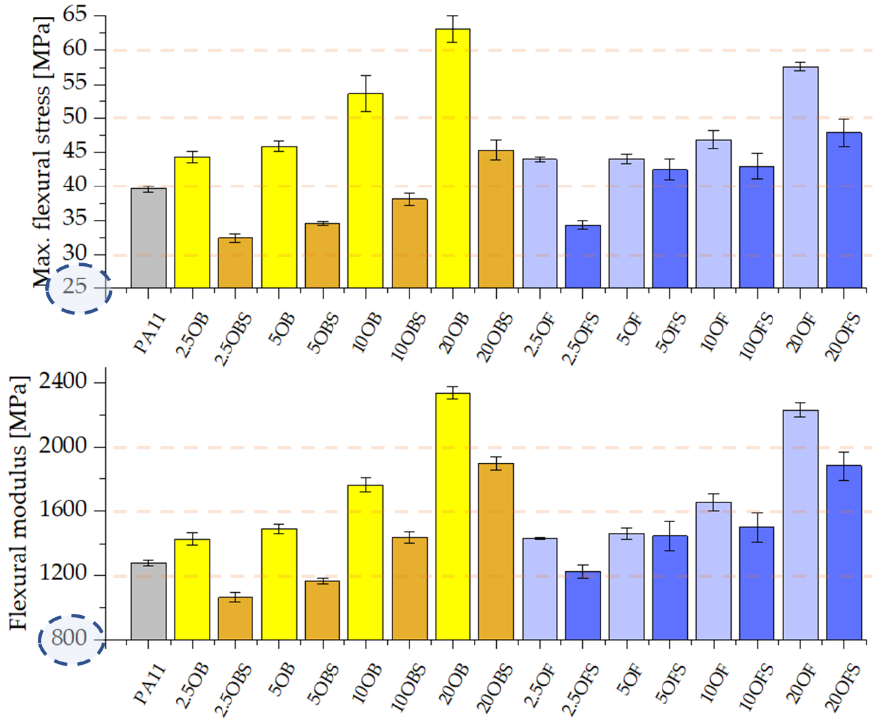
Figure 9. Maximum flexural stress and flexural modulus of PA11 composites containing silanized and non-silanized diatomite.